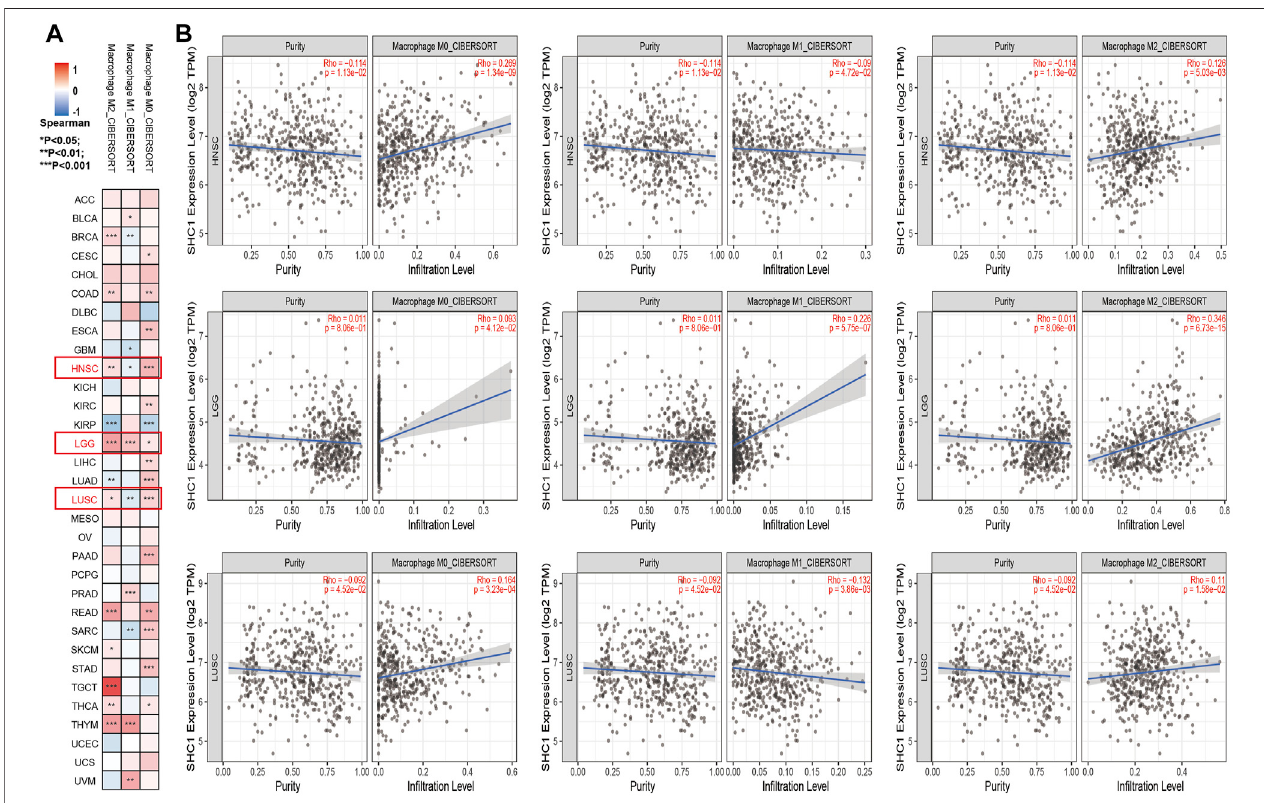
FIGURE 9 | Correlation analysis between SHC1 expression and tumor-associated macrophages (TAMs). (A) CIBERSORT algorithms were used to explore the potentialcorrelation between the expression level ofthe SHC1 gene and the in fi ltration level of cancer-associated fi broblasts across all types ofcancer inTCGA. (B) The correlation analysis chart of HNSC, LGG, LUSC are given.